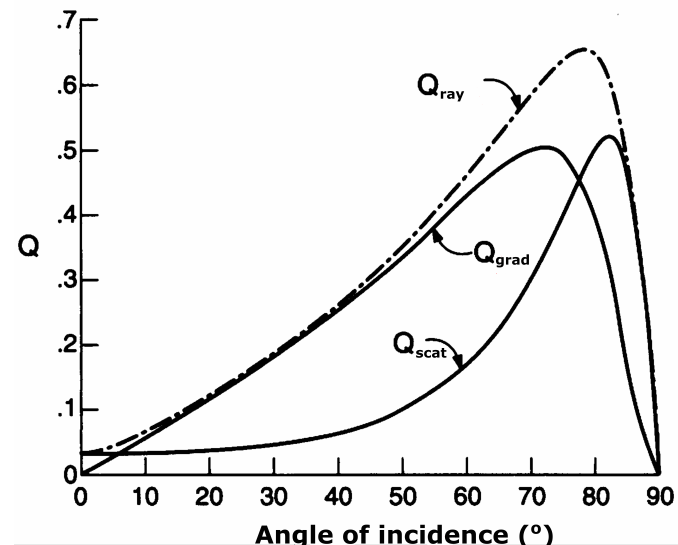
Figure 3. The calculated Q factors for the gradient, scattering, and total trapping efficiencies for a single circularly polarised ray acting on a spherical dielectric particle of effective refractive index n m , ef f = 1.2, as a function of the incident angle. Figure reproduced with permission from